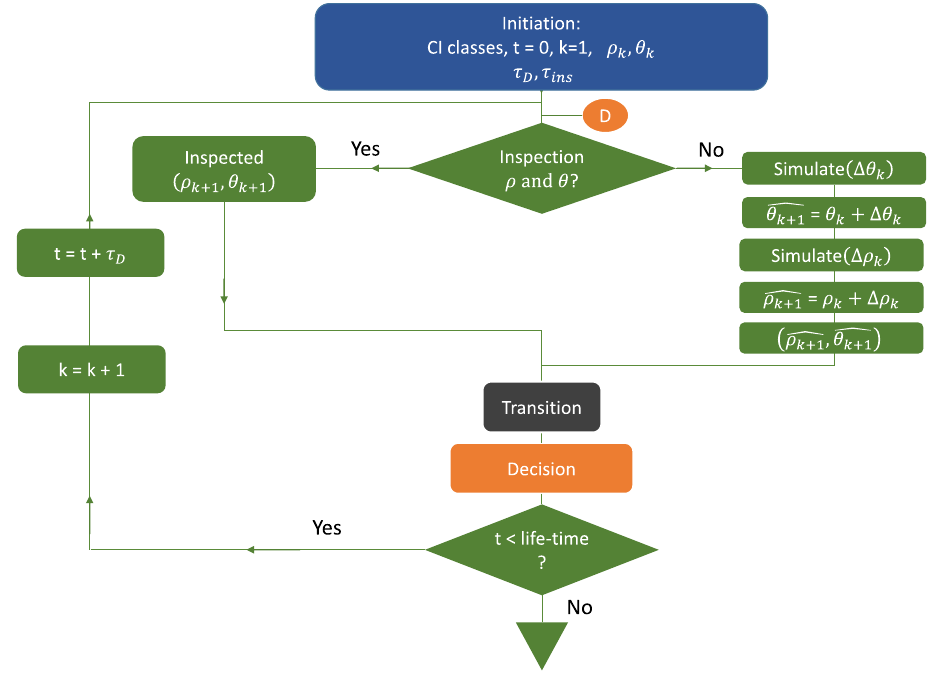
Figure A1. General flowchart of the proposed